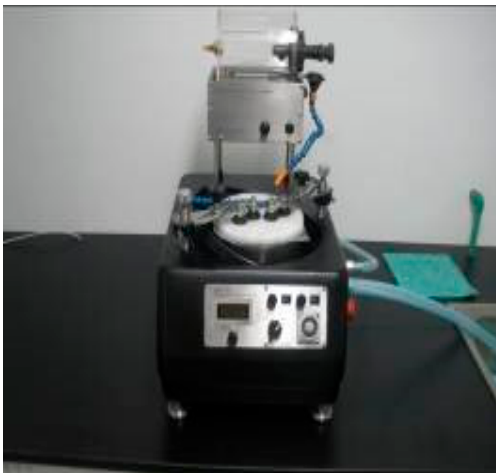
Figure 4. Polishing instrument.